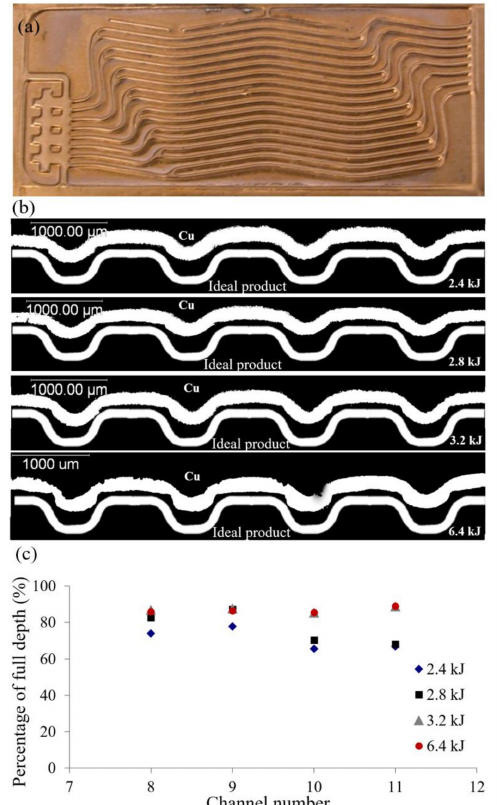
Figure 6. ( a ) The deformed Cu110 sheet with magnetic pulse forming; ( b ) a cross-sectional profile of the deformed Cu110 sheet at capacitor bank energies of 2.4 kJ, 2.8 kJ, 3.2 kJ, and 6.4 kJ; and ( c ) the channel depth of the deformed Cu110 sheet at capacitor bank energies of 2.4 kJ, 2.8 kJ, 3.2 kJ, and 6.4